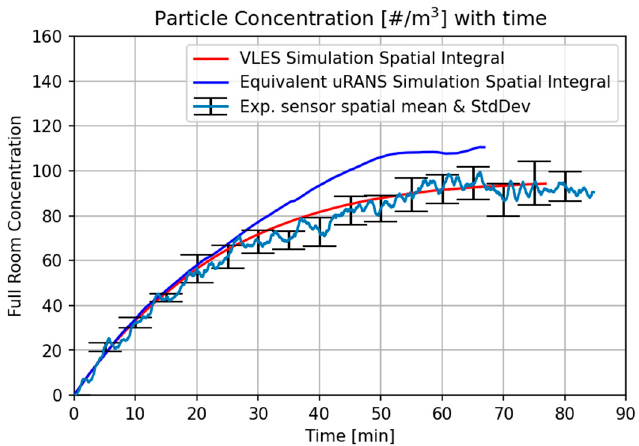
Figure 13. Particle modelling concentration of particles inside room and comparison between VLES and equivalent